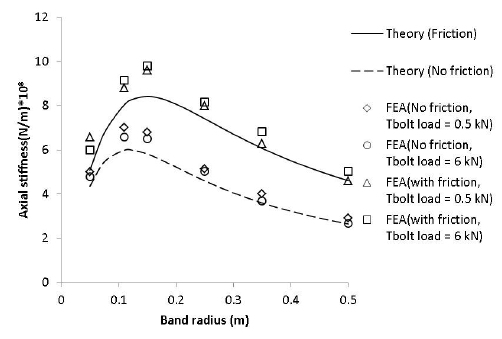
Figure 15: Axial stiffness for different band sizes (theory and FEA, T-bolt load =0.5 kN and 6 kN) with friction ( µ =0.15) and without friction.